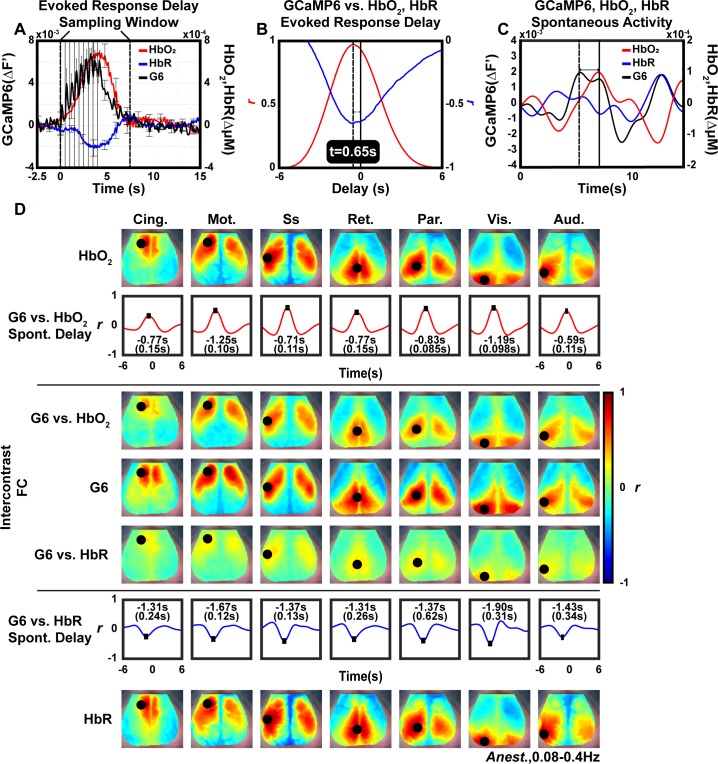
Intercontrast functional connectivity mapping in the anesthetized state.Based on the temporal delay between evoked GCaMP6 and HbO2/HbR responses combined with similar observed 0.08–0.4Hz functional connectivity structure, delay-shifted GCaMP6 likely shares functional network information with HbO2 and HbR. (A) GCaMP6 (black), HbO2 (red), and HbR (blue) evoked responses to 2Hz 0.5mA electrical stimulation of left hind paw (see Fig 2B and 2C). Data from a sampling window spanning from approximately t = 0s to t = 7.5s were included in subsequent cross-correlational delay analysis. (B) Cross-correlation from the GCaMP6 and HbO2 time courses in (A), and the GCaMP6 and HbR time courses in (A), both show a delay of 0.65s between responses. (C) An example of spontaneous GCaMP6, HbO2, and HbR time traces from the right motor cortex seed over the 0.08–0.4Hz band. HbO2 and HbR data was shifted based on the lag with the maximum correlation calculated between the spontaneous hemoglobin data and spontaneous GCaMP6 data per seed (as shown by arrows). (D) Top and Bottom: Seed-based group-averaged functional connectivity mapping in filtered (0.08–0.4Hz) anesthetized data using HbO2 (top) or HBr (bottom) and cross-correlation curves (with mean delays of maximum correlation in black text with standard errors of the mean in parenthesis) between each HbO2 network seed trace and corresponding GCaMP6 seed trace. Middle: Seed-based GCaMP6 functional connectivity maps and corresponding intercontrast seed-based functional connectivity maps for GCaMP6 vs temporally-shifted HbO2 (top) and GCaMP6 vs temporally-shifted HbR (bottom). Correlation between spontaneous HbO2 and GCaMP6 contrasts (filtered between 0.08–0.4Hz) are better optimized by removing the intercontrast time shift between these contrasts compared to the analogous correlation between spontaneous HbR and GCaMP6 contrasts.